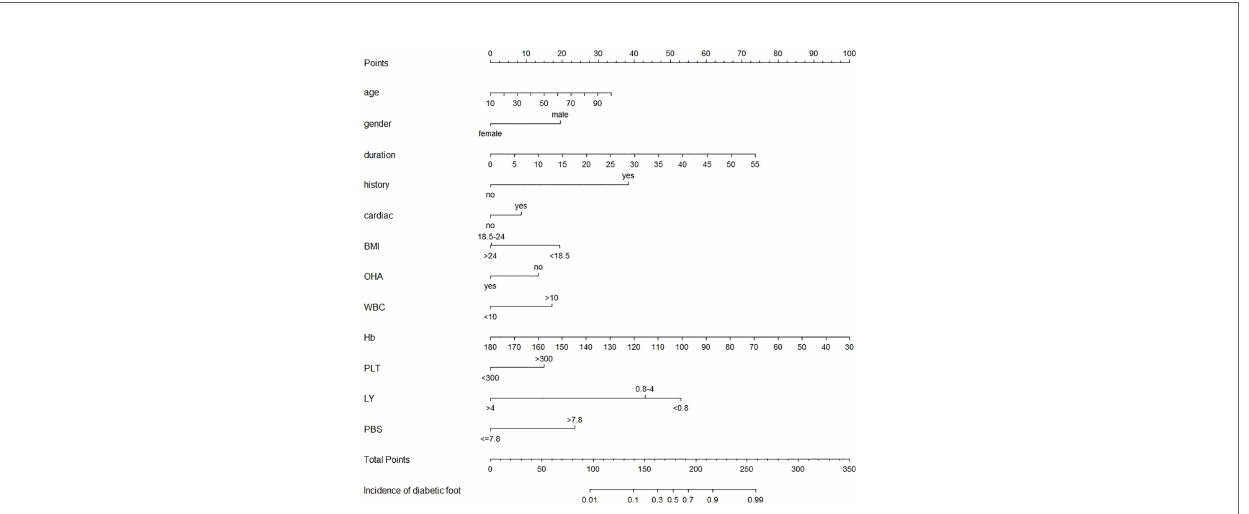
FIGURE 1 | Nomogram to estimate the risk of DFU in patients with diabetes. To use the nomogram, fi nd the position of each variable on the corresponding axis, draw a line to the points axis for the number of points, add the points from all variables, and draw a line from the total point axis to determine the DFU probabilities at the lower line of the nomogram. cardiac, cardiac insuf fi ciency; DFU, diabetic foot ulcer; BMI, body mass index; Hb, hemoglobin; LY, lymphocyte absolute value; OHA, oral hypoglycemic agent; PBS, postprandial blood glucose; PLT, platelet; WBC, white blood cell.